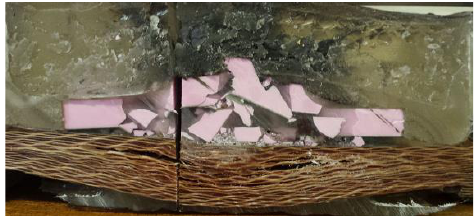
Figure 3 : Illustration of delamination in a 2D woven composite backing